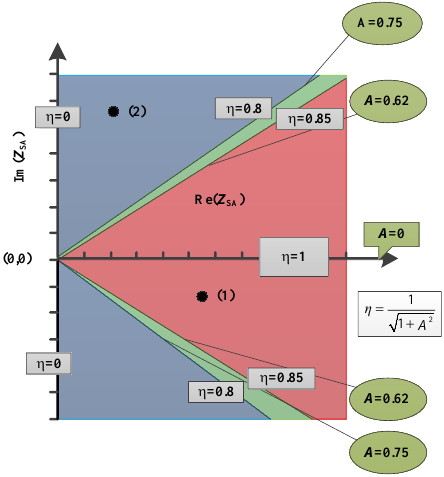
Figure 6. Schematic diagram of A - η on Z SA impedance plane.